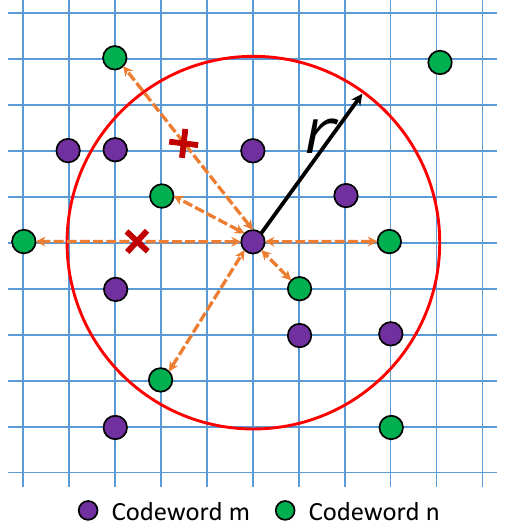
Figure 4. Illustration of computing the spatial codeword co-occurrence matrix WCM ( m , n ) . Only the codeword pairs within the distance constraint r are valid. In this way, we can discover the local spatial properties of the coding image.